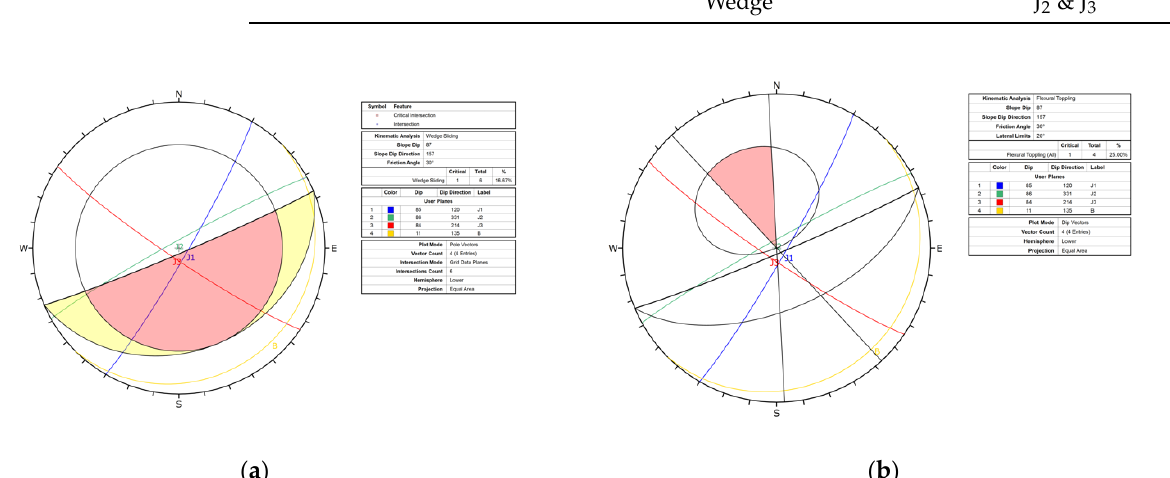
Figure 10. Kinematic analysis for: ( a ) wedge sliding and ( b ) flexural toppling failure in sub-region U1.